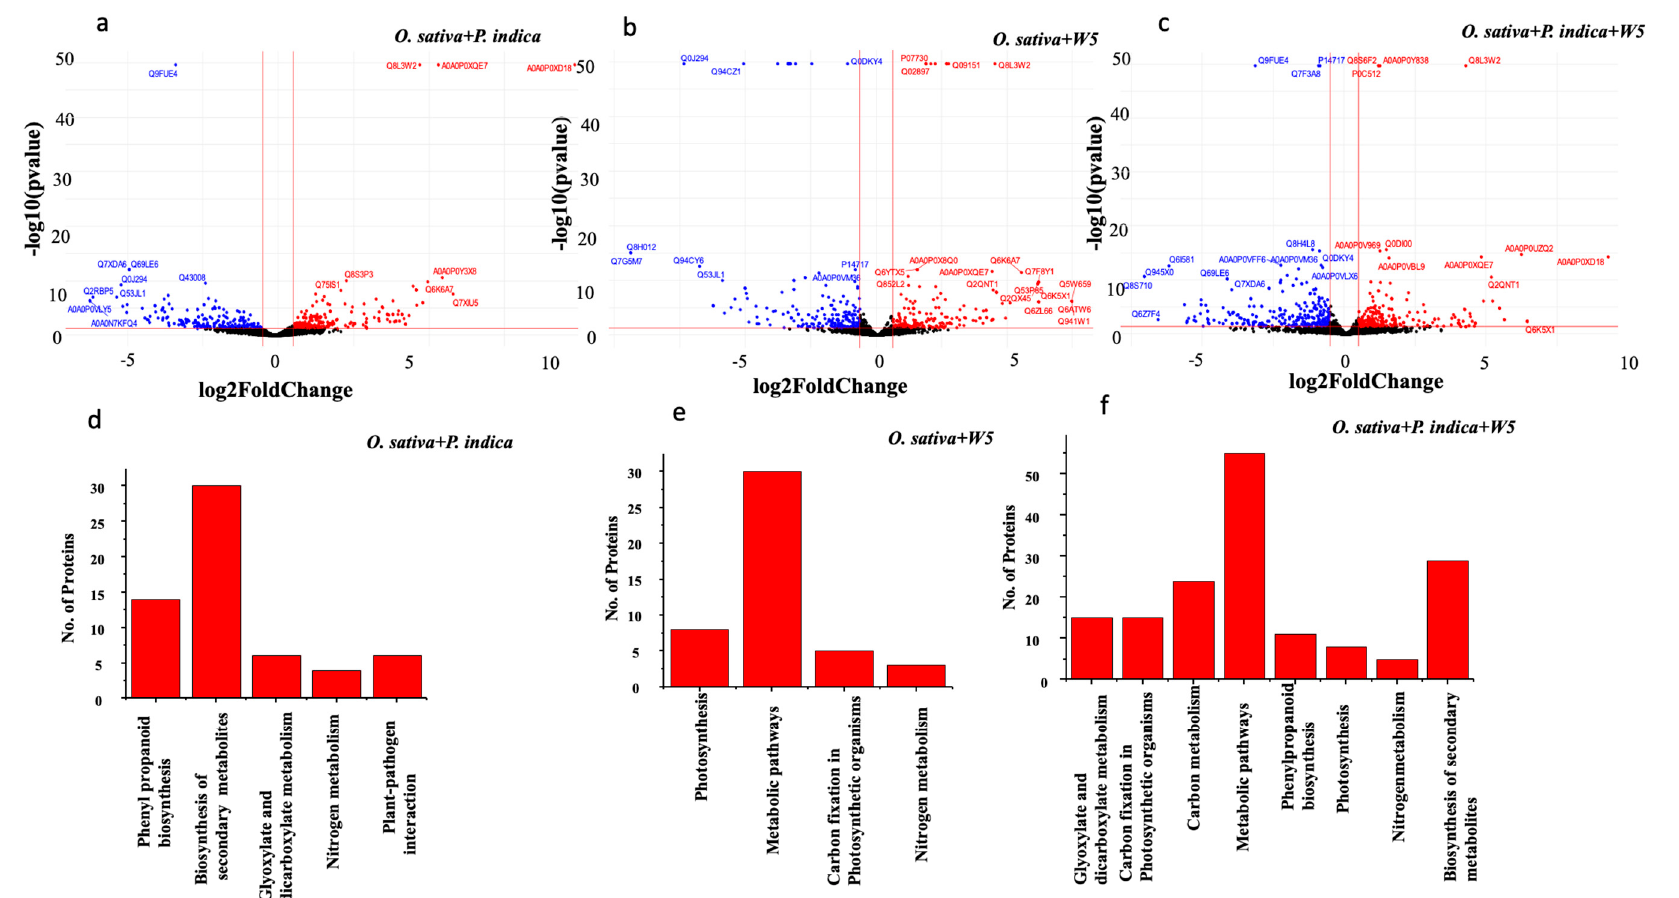
Figure 6. Significantly differentially abundant proteins with 0.5-fold up and down regulation and KEGG pathway enrichment. ( a ) Volcano plot for the differentially abundant proteins identified in O. sativa when inoculated with P. indica after 21 days of interaction. Proteins that were significant ( p -value < 0.05) and upregulated are indicated by the color red, significantly downregulated proteins are indicate d by the color blue, and the color black indicates DAPs that were insignificant. ( b ) Volcano plot of DAPs in O. sativa inoculated with W5. ( c ) Volcano plot of DAPs in O. sativa co-inoculated with W5 and P. indica. ( d – f ) KEGG pathway enriched ( p -value p < 0.05) by upregulated DAPs in O. sativa inoculated with P. indica, W5 alone, and in combination of both.